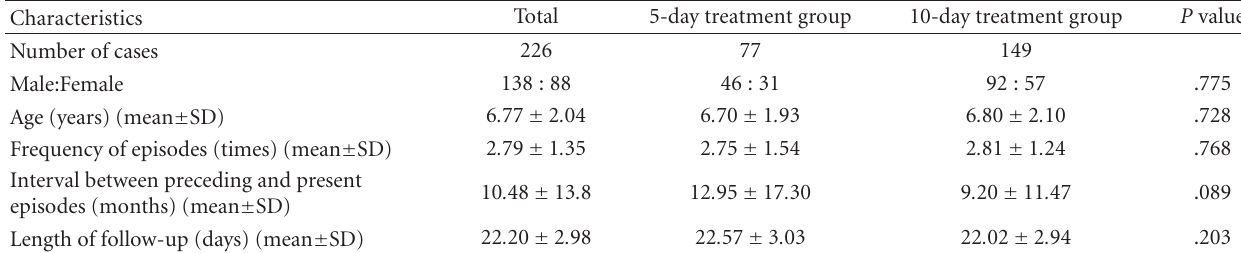
Table 1: Characteristics of children with repeated GABHA